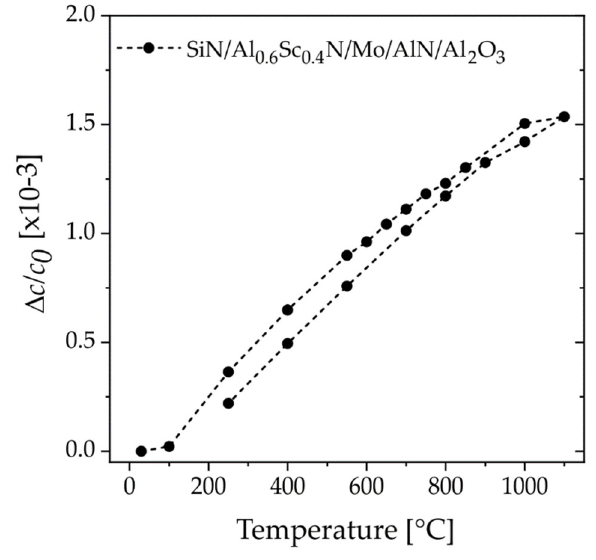
Figure 8. XRD in situ (with oxygen atmosphere) experiment. Relative change in lattice parameter c with temperature for epitaxial SiN x /Al 0.6 Sc 0.4 N(0001) on a template of epi-Mo(110)/AlN(0001)/Al 2 O 3 (0001) (sample set #3).